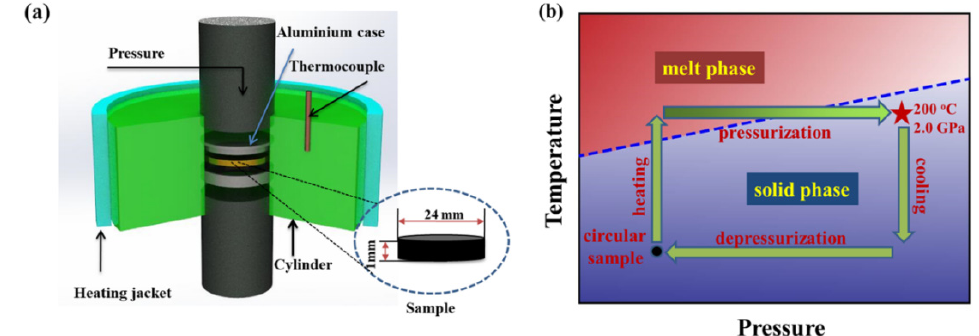
Figure 1. ( a ) Schematic of the high-pressure cell; ( b ) preparation diagram of pressurization treatment.